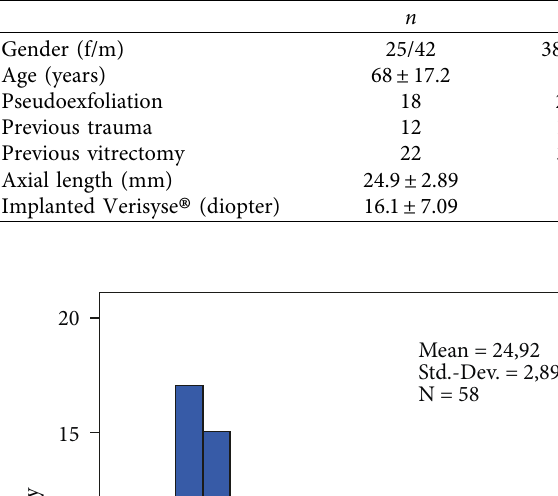
Figure 3: Distribution of the implanted lens (dioptres).